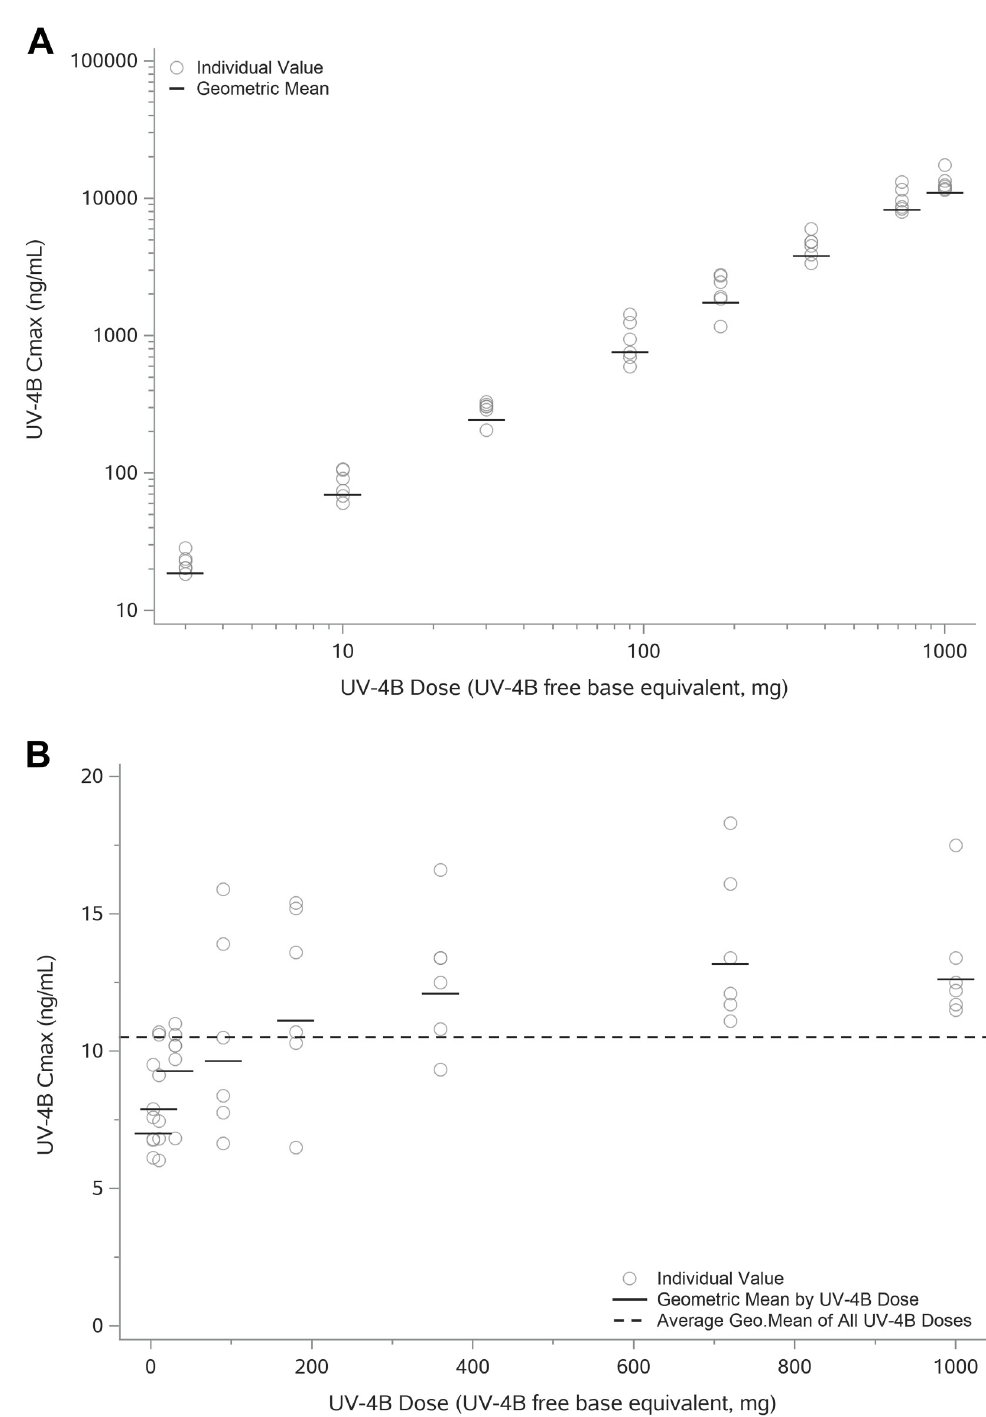
Fig 5. Individual and Geometric Mean of C max versus Administered Dose. A . Individual and geometric mean of C max represented using log-scale. Overall C max appears to increase in a dose proportional manner. B . Individual and geometric mean of Dose Normalized C max (DNC max ) (linear scale). There is considerable overlap in the range of individual DNC max values, with a trend of a slightly greater than proportional increase in C max over the 3 to 180 mg UV-4 dose range. The range and mean DNC max values were similar across the 360 to 1000 mg dose range. Dose proportionality was assessed utilizing a power model, the slope was approximately 1.1 over either the 333-fold (3 to 1000 mg) or the 33-fold (30 to 1000 mg) UV-4